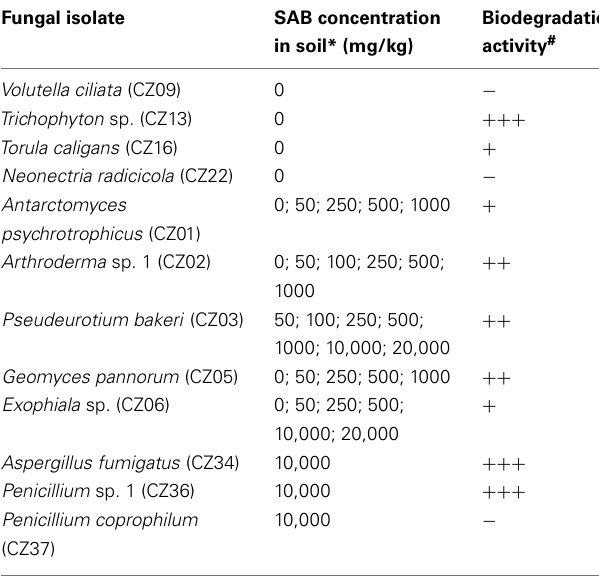
Table 5 | Biodegradation activity of a selection of isolates with SAB diesel fuel as the sole carbon